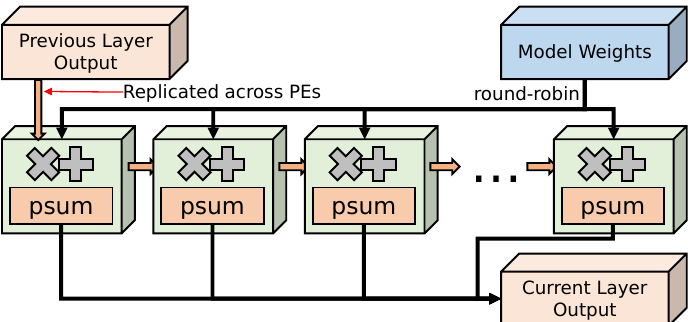
Figure 5. Output stationary accelerator architecture for large models.